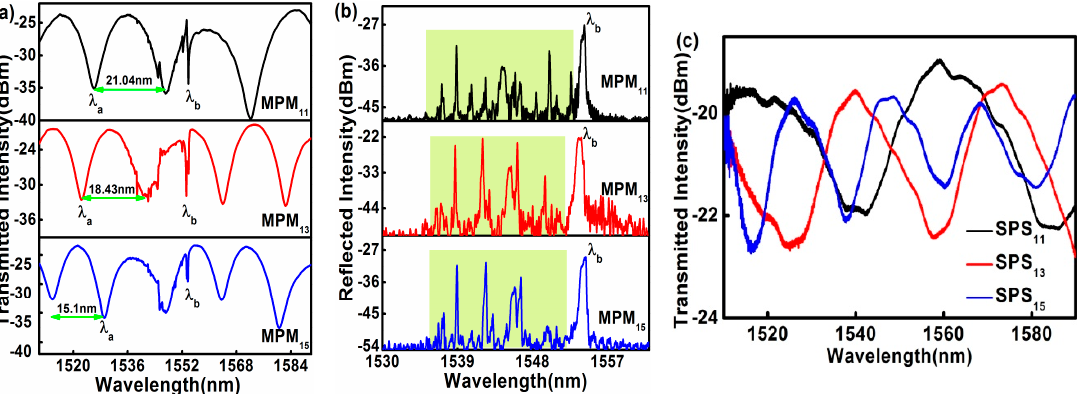
Figure 4. Spectra of MPMs cascaded with a FBG: ( a ) transmission spectra; ( b ) reflection spectra; and ( c ) the transmission spectra of SPS.